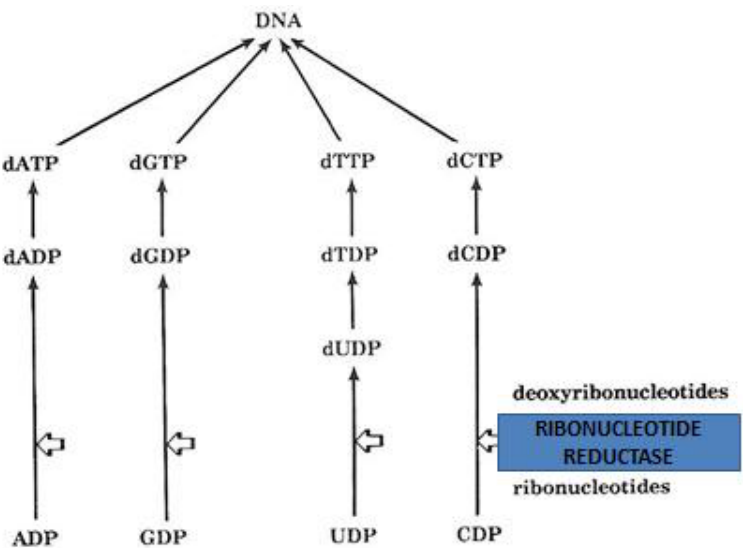
Figure 4. The mode and site of action of the iron-containing enzyme ribonucleotide reductase, which is essential for DNA synthesis. Ribonucleotide reductase is responsible for the conversion of ribonucleotides (ADP: adenosine diphosphate; GDP: guanosine diphosphate; UDP: uridine diphosphate; and CDP: cytidine diphosphate) to deoxyribonucleotides (dADP: deoxyadenosine diphosphate; dGDP: deoxyguanosine diphosphate; dUPD: deoxyuridine diphosphate and dCDP: deoxycytidine diphosphate. The nucleotides dATP, dGTP, dTTP and dCTP (deoxy nitrogen-based triphosphates) are then formed in cells and used for DNA synthesis.